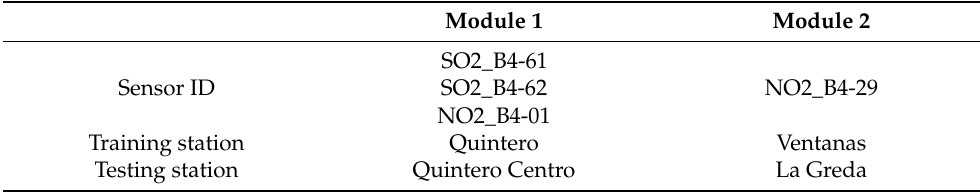
Figure 6. Location of the air quality monitoring stations used for training and testing the sensors. The major industrial facilities located along the bay are indicated by numbers: (1) coal-based power plant, (2) copper smelter-refinery, and (3) oil discharge and storage facility. Table 2. Identification of the sensors deployed in the monitoring stations.